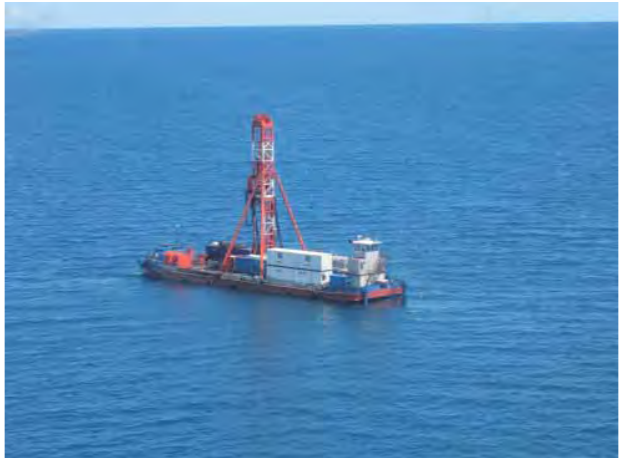
Figure 3. The Viphya drilling barge in central Lake Malawi.